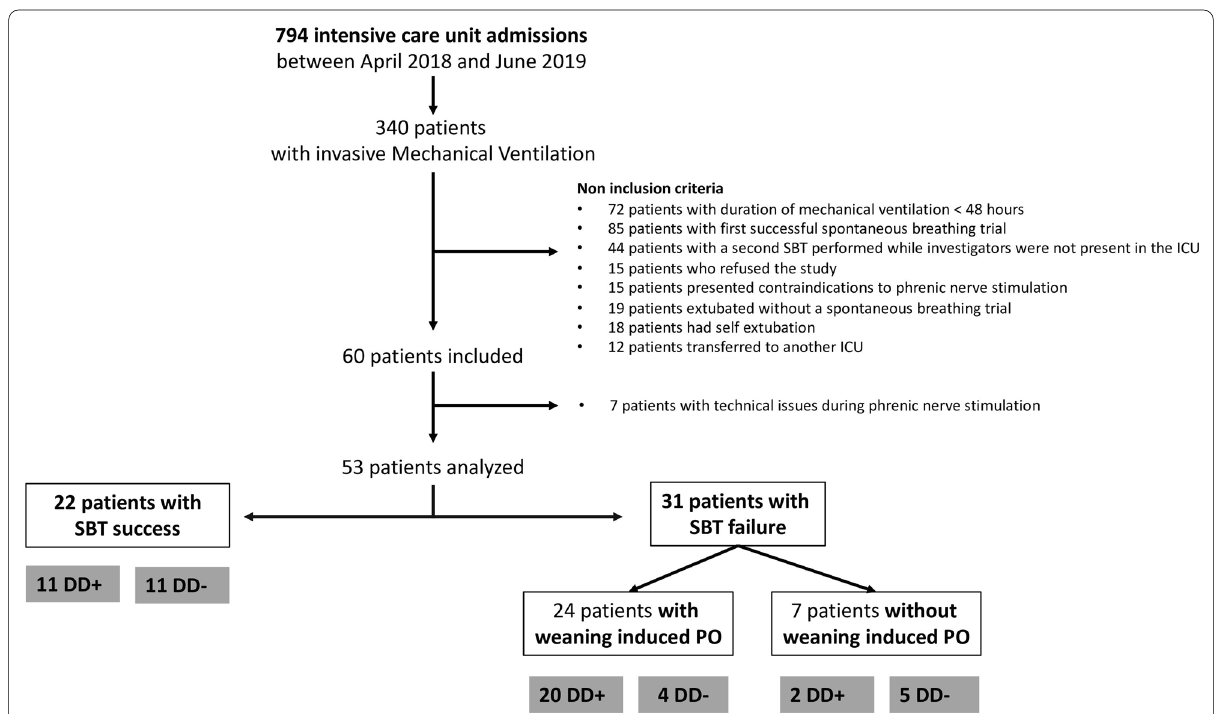
Fig. 1 Study flowchart. ICU: intensive care unit; SBT: spontaneous breathing trial; PO: pulmonary oedema; DD: diaphragm